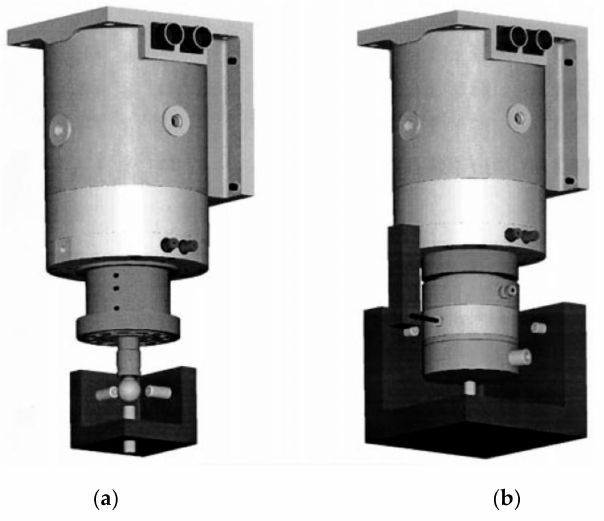
Figure 45. Traditional measurement of error movements ( a ) and using the master axis ( b ) [38]. The master axis, on aerodynamic bearings, is mounted directly in the machine tool spindle–Figure 46. The master axis body is locked to prevent it from turning using a high stiffness master axis with low radial error.